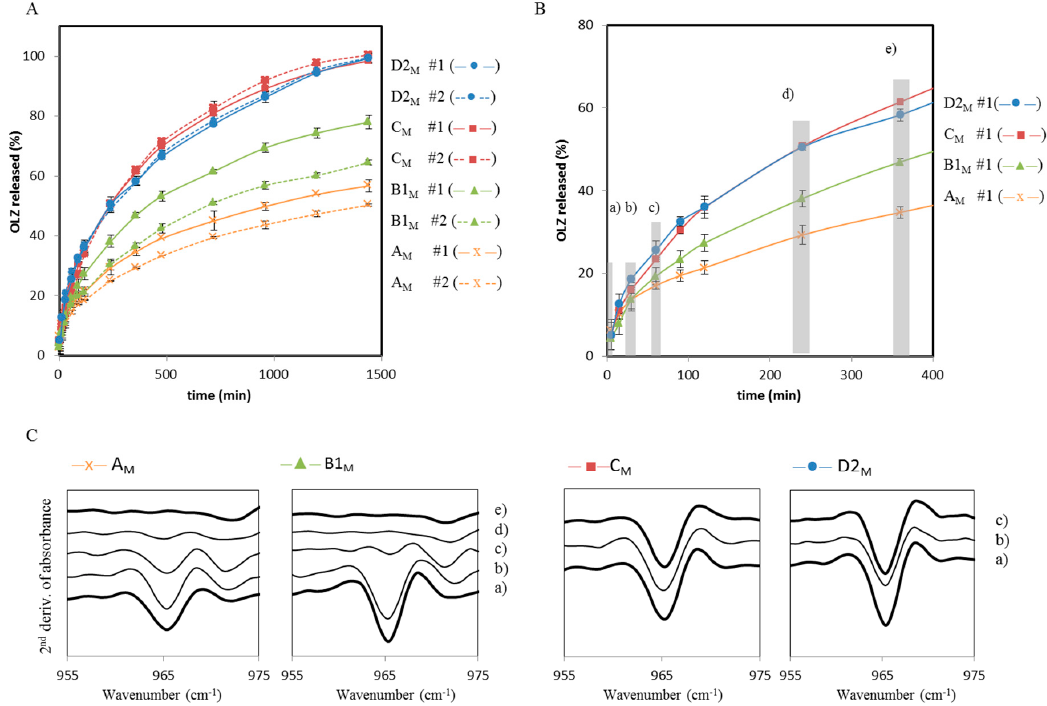
Figure 9. Dissolution profiles of OLZ from pellets (top) and Spectra (FTIR) analysis made from different formulations (A M , B1 M , C M and D2 M ). ( A ) Dissolution profiles of OLZ from pellets #1 ( t = 0 min) and #2 ( t = 360 min); ( B ) Formulations and the time periods (a–e) in which pellets were collected for FTIR characterization; ( C ) Second derivative of FTIR absorbance spectra from collected samples (times a–e for formulations A M and B1 M and times c–d for formulations C M and D2 M ).